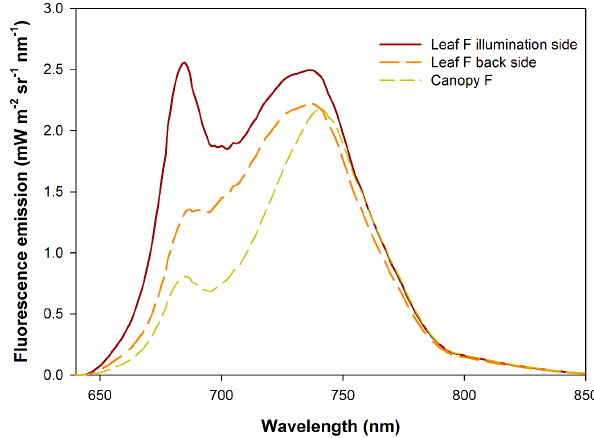
Figure 4. Spectral shapes of fluorescence emission at the leaf level in the illumination and back-side and at the canopy level for a nadir observation simulated with the SCOPE model. The grass leaf emission spectrum was simulated with the following inputs: leaf chlorophyll concentration of 29 µg·cm − 2 , equivalent water thickness of 0.00207 cm, dry matter content of 0.001 g·cm − 2 , senescent material of 0.148, leaf structure parameter N of 1.5. Simulated leaf is perpendicular to the solar beam. The canopy spectrum has been simulated for the control grass reported in [12] at noon with a Leaf Area Index of 4.3 m 2 ·m − 2 .